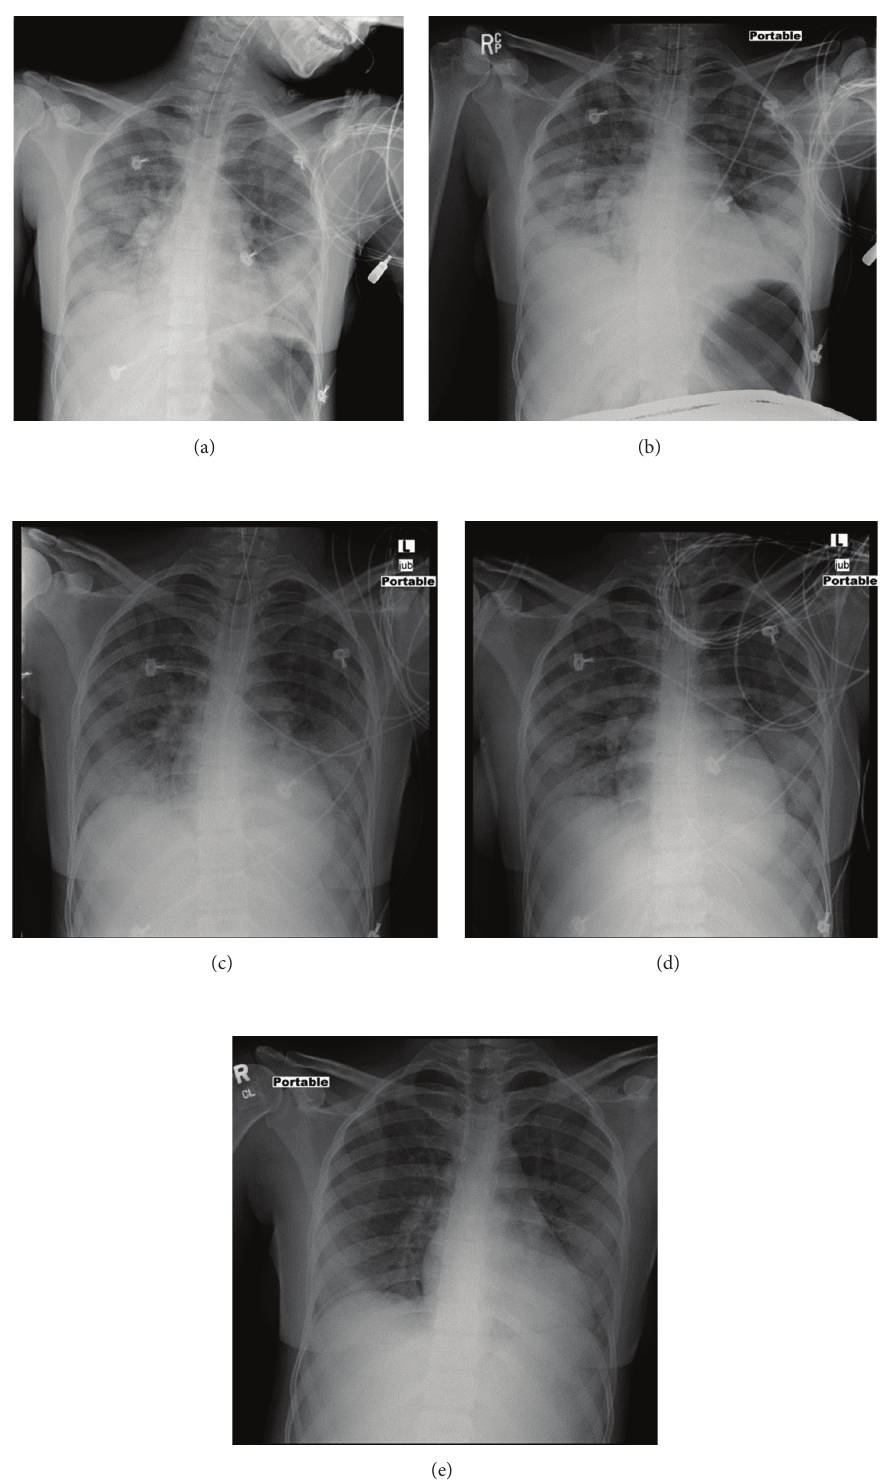
Figure 3: (a)–(d) Endotracheal tube is noted with the tip ending at the satisfactory position. An enteric tube has been placed. Diffuse bilateral hazy opacification is again seen, which gradually improved in sequential (a)–(d) chest radiographs. (e) Chest radiograph showing marked improvement in previously seen bilateral hazy opacities after